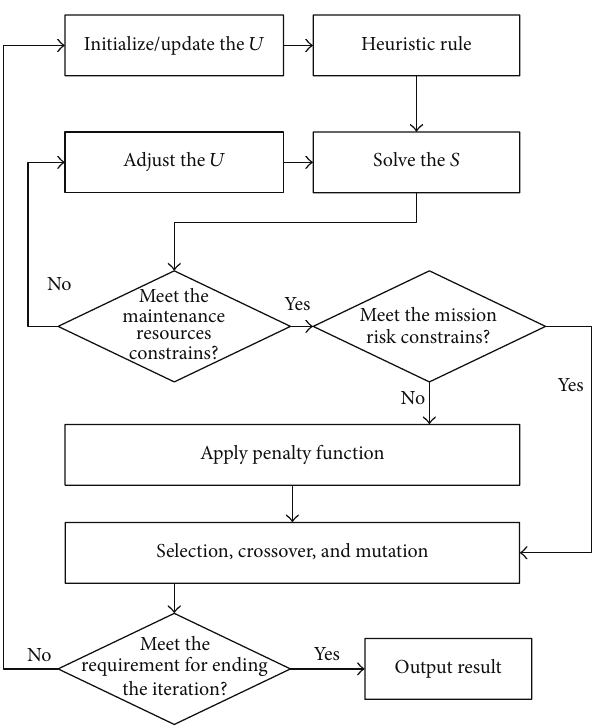
Figure 3: Improved strategies for genetic